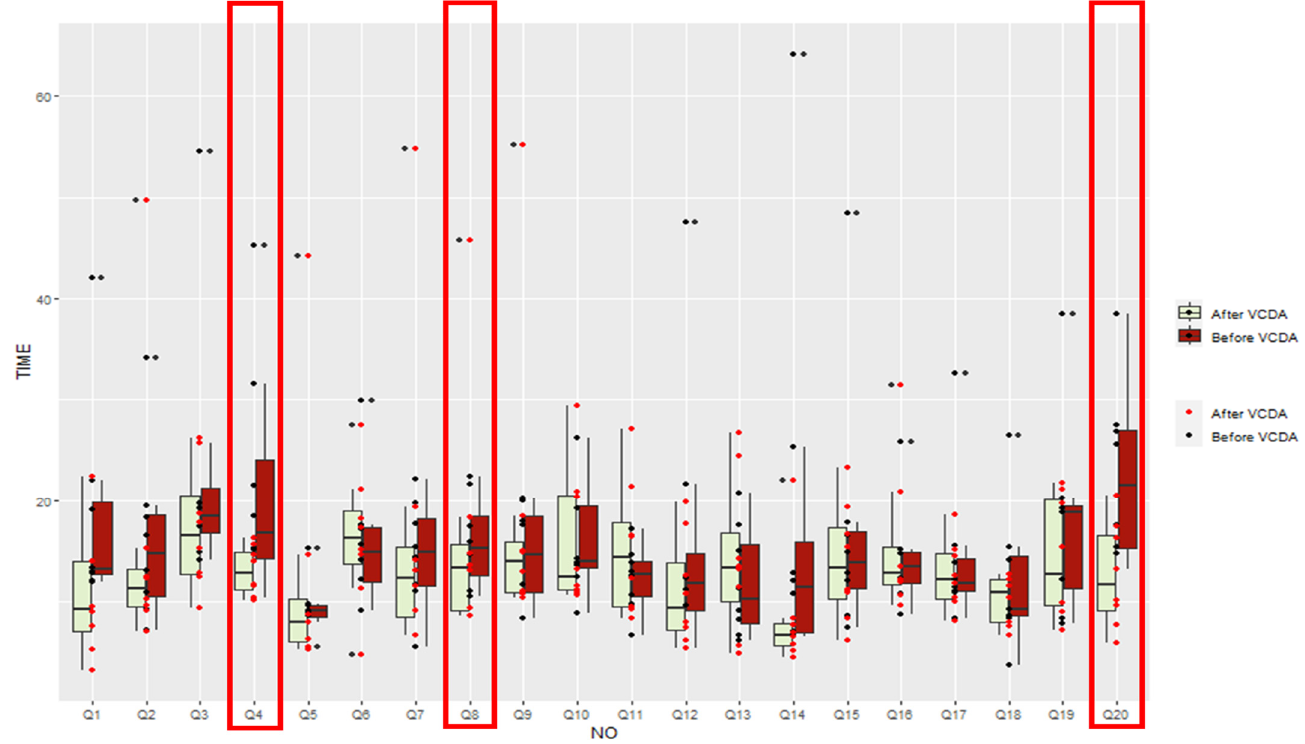
Figure 3. Comparison of information recognition speed before and after VCDA in Group A (low vision).